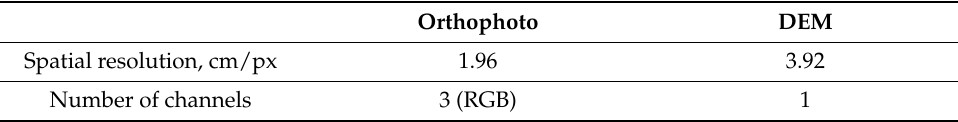
Table 1. Results of photogrammetry processing of UAS